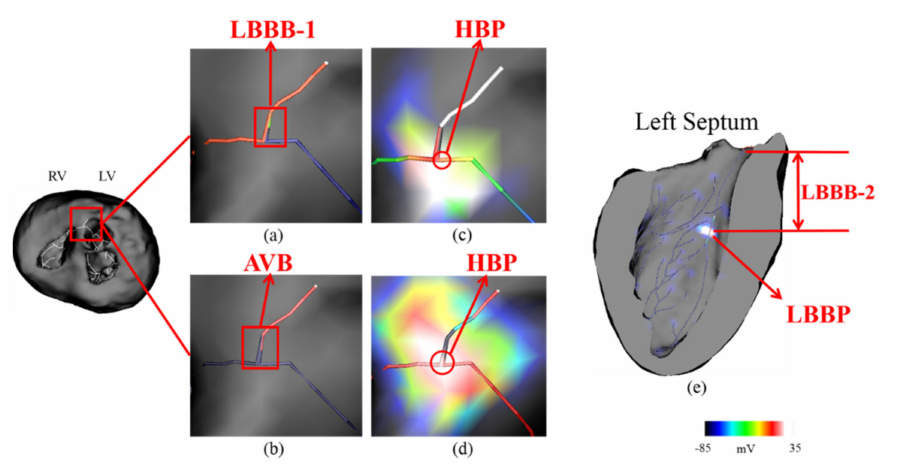
Figure 2. ( a ) LBBB occurs within the His-bundle. Red color represents that the His-bundle and RBB were excited (according to the color bar). ( b ) AVB occurs within the distal His-bundle. The excitation could not be conducted through the His-bundle. ( c ) HBP stimulus initiated at the left side end of the distal His-bundle. ( d ) HBP stimulus initiated at the distal end of His-bundle. ( e ) LBBB occurs in the left main bundle branch, and the LBBP stimulus was performed at the distal end of the left main branch, beyond the block. The transmembrane potential is illustrated by the color bar. LBBB: left bundle branch block. RBB: right bundle branch. HBP: His-bundle pacing. AVB: atrioventricular block. LBBP: left bundle branch pacing. LBB: left bundle